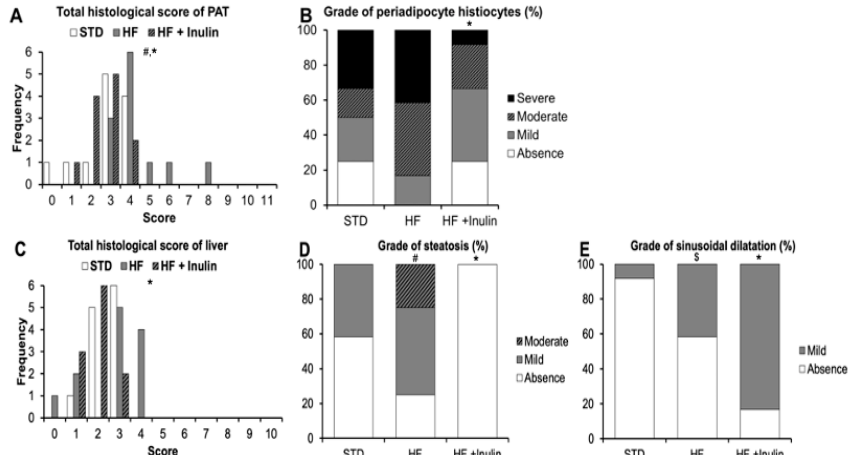
Figure 4. Histological analysis of perigonadal adipose tissue and liver samples. ( A ) Total histological score of perigonadal adipose tissue (PAT) sample. ( B ) Grade of periadipocyte histiocytes. ( C ) Total histological score of liver sample. ( D ) Grade of steatosis in liver. ( E ) Grade of sinusoidal dilatation in liver. Results are expressed in frequencies (absolute or %), n = 12 rats/group. Abbreviations: STD, standard diet; HF, high-fat diet; HF + Inulin, modified HF diet containing 15% inulin. p -values were calculated using the non-parametric Mann–Whitney U test. # p -value < 0.05 vs. STD; $ p -value = 0.065 vs. STD; and * p -value < 0.05 vs. HF.